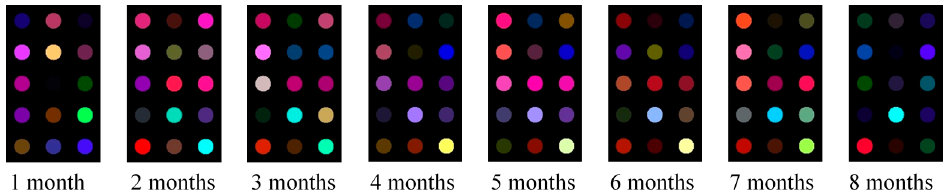
Figure 3. Differences in the olfactory visualization characteristics of rice samples over a monthly range of storage intervals.